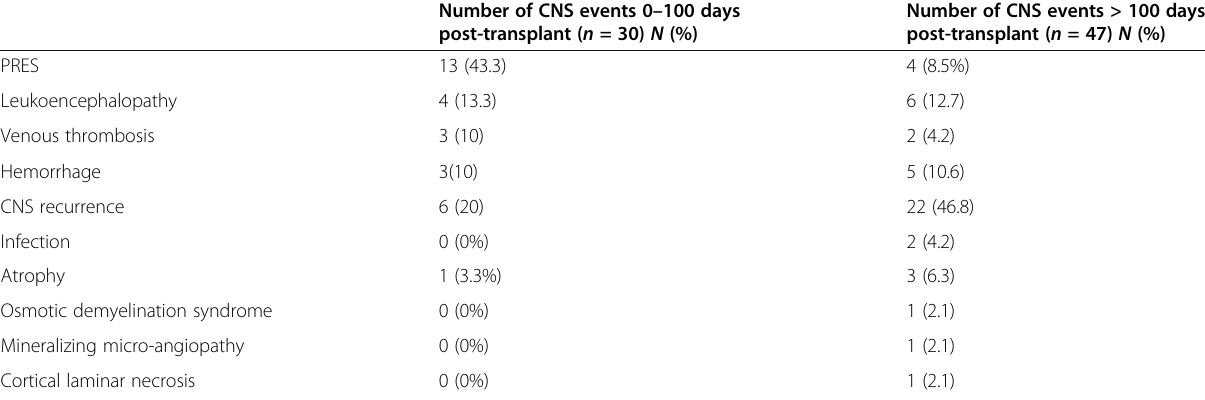
Table 3 Incidence of CNS complications > 100 days and > 100 days post-HSCT